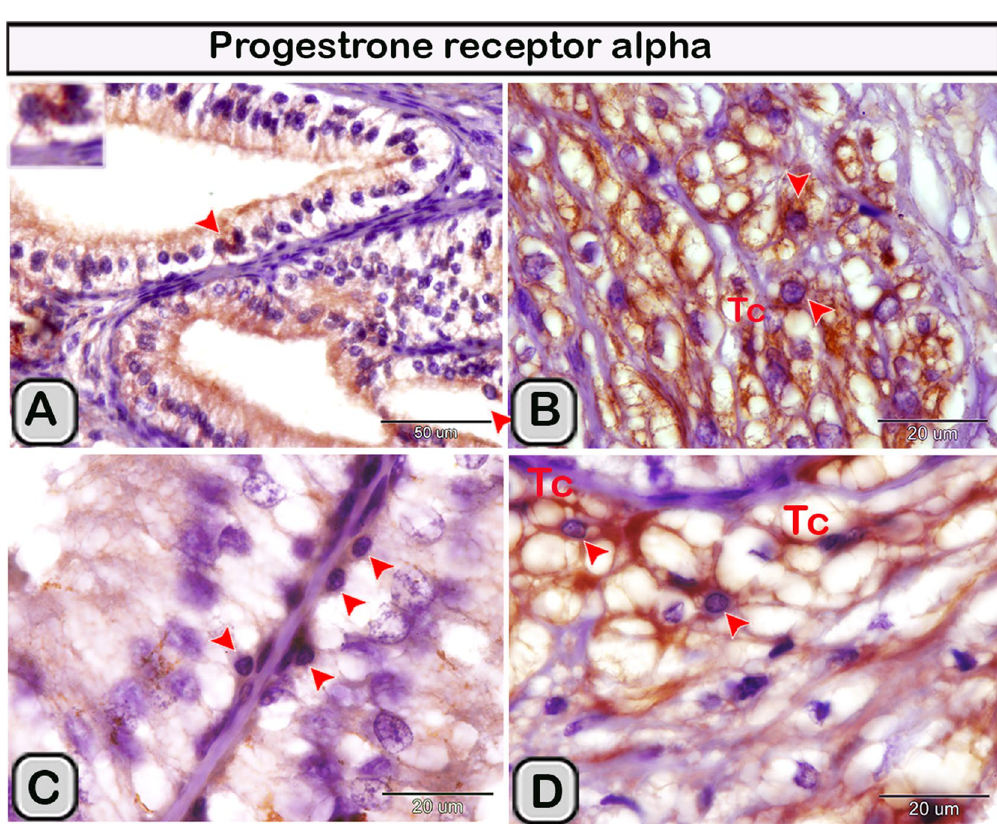
Figure 7. The effect of melatonin administration on the expression of progesterone in the DCs (red arrowheads). (A,B) Expression of progesterone receptor in the DCs in the epithelium and the interstitium of the control groups respectively. (C,D) The expression of progesterone receptors increased obviously in the melatonin treated groups. Notice: the close relation between the DCs (red arrowheads) and TCs